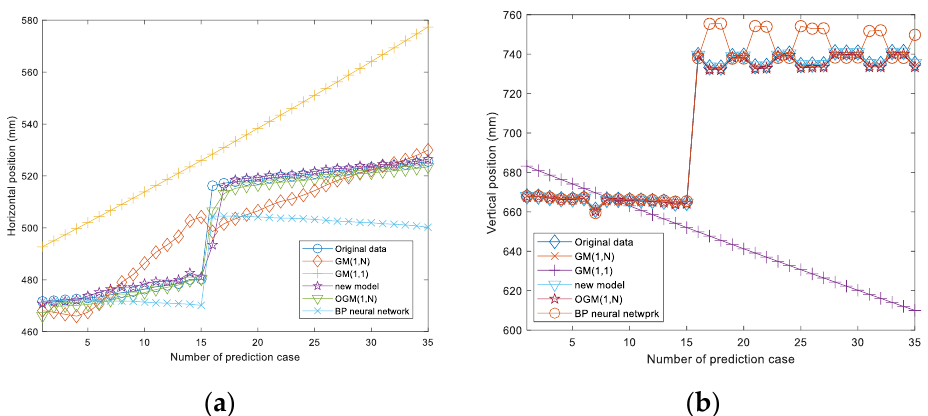
Figure 14. The curve of prediction for sensing unit 1. ( a ) Graph of horizontal displacement prediction effect of sensing unit 1. ( b ) Graph of vertical displacement prediction effect of sensing unit 1.